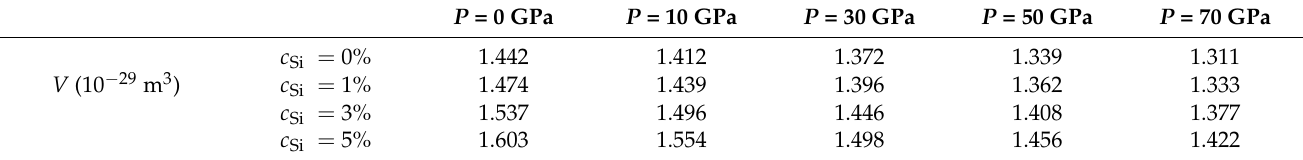
(cid:0) (cid:1) 10 − 29 m 3 for WSi at T = 300 K.